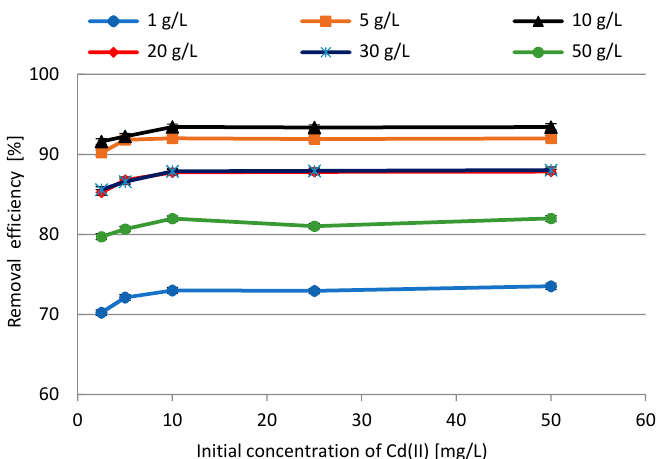
Figure 12. The impact of initial concentration of Cd(II) ions on BG residues removal efficiency.